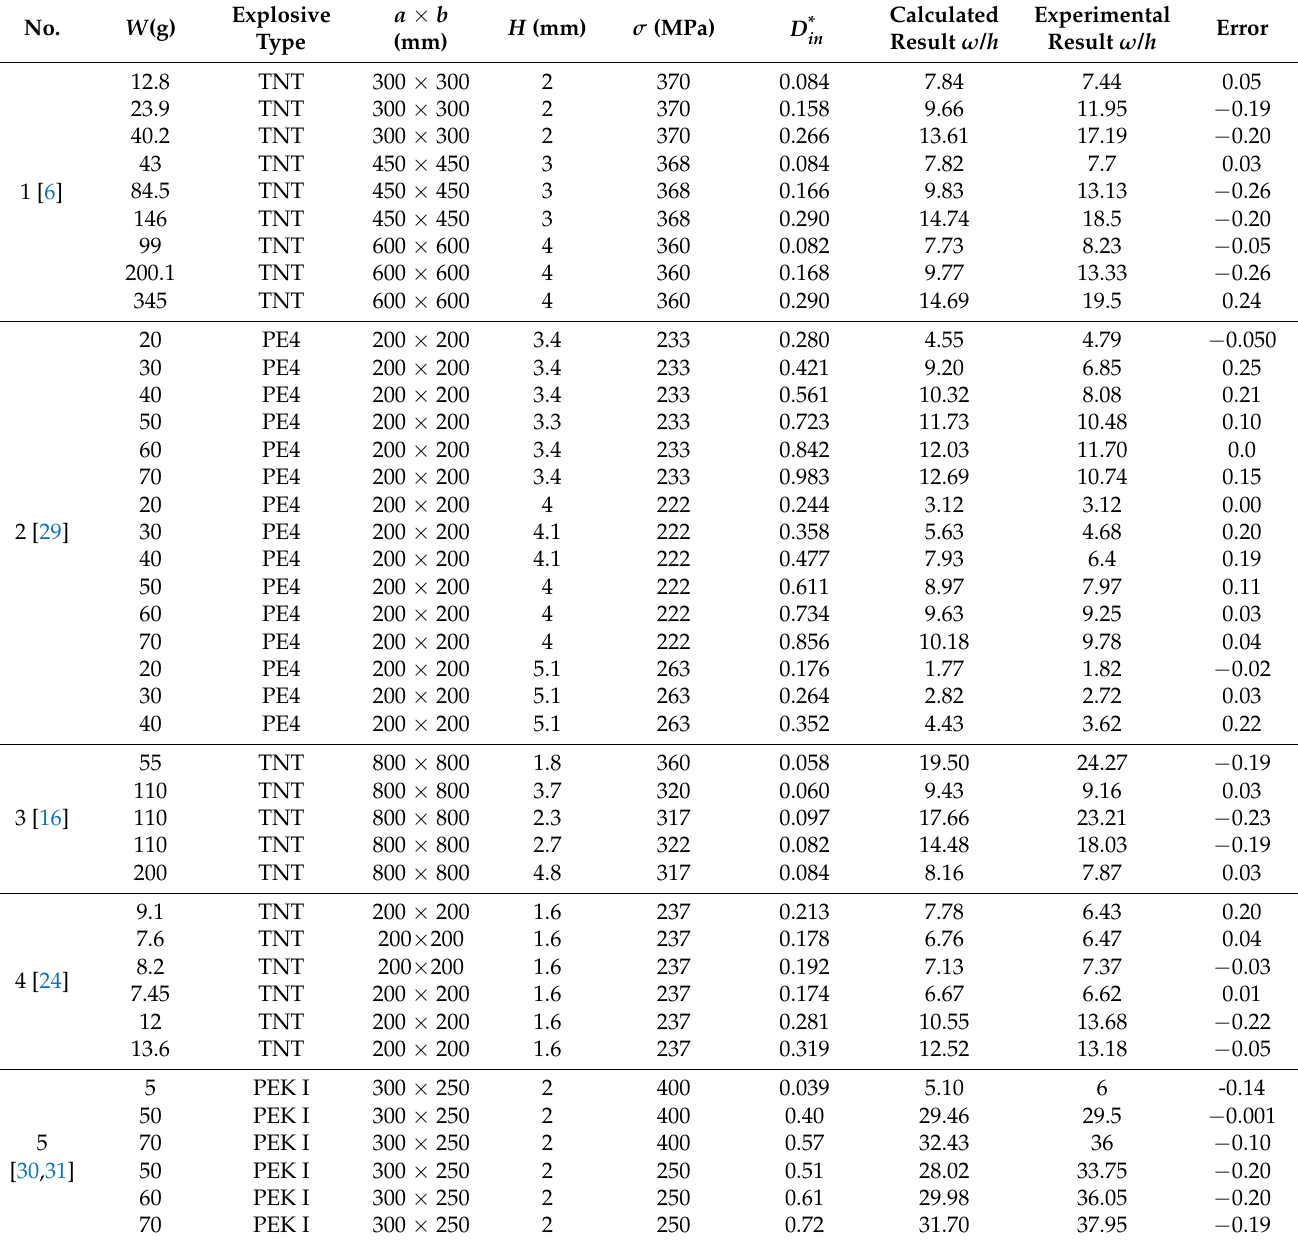
Table 8. Experimental conditions and analysis